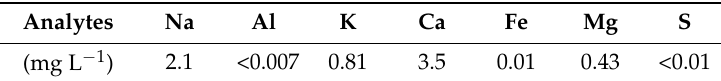
Table 1. ICP-OES result.